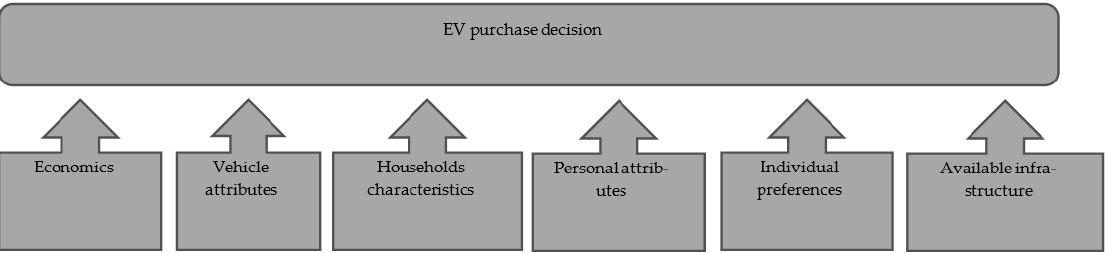
Figure 2. Groups of factors influencing EV purchase decisions.